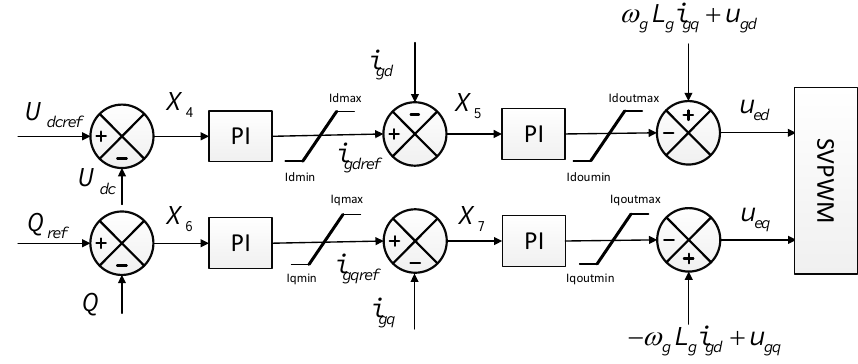
Figure 4. Control diagram for grid-side converter (GSC).